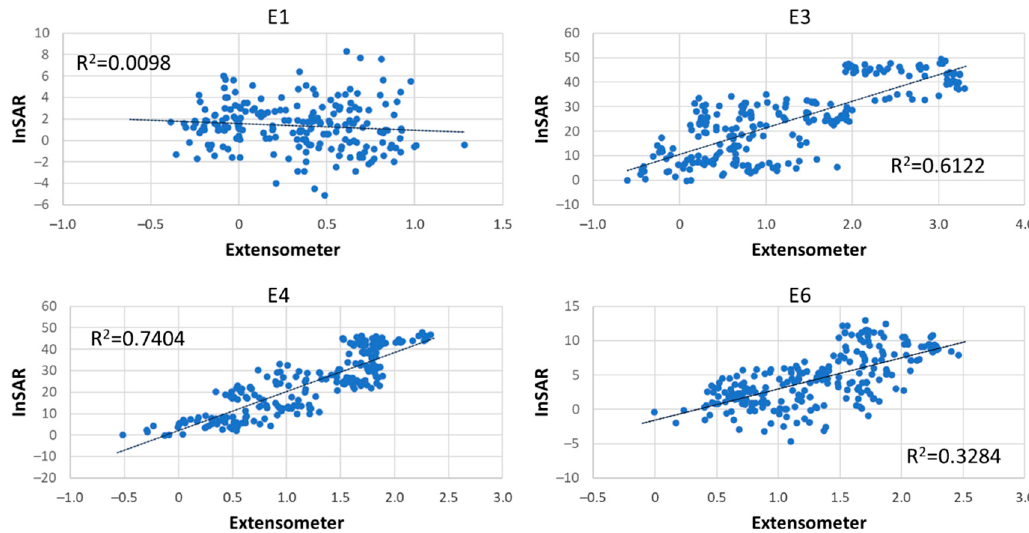
Figure 14. Correlation graphs between MT-InSAR and extensometer data for four measurement points (E1, E3, E4 and E6).